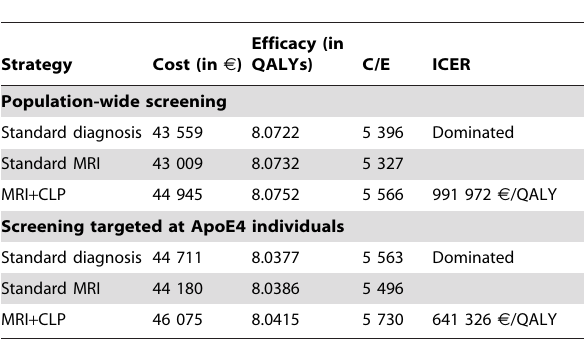
Table 4. Results of the ‘‘screen and treat’’ analyses (base-case hypothesis): computed cost, efficacy and cost-effectiveness (C/E) ratio of the standard diagnosis, standard MRI and MRI + CLP strategies, and incremental cost-effectiveness ratio (ICER) of the MRI + CLP strategy as compared with the standard MRI